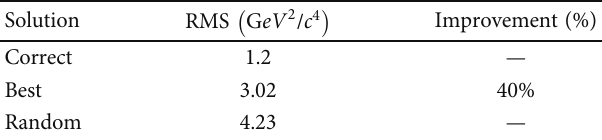
Figure 6: The fl owchart of the methodology. Table 2: Resolution on reconstructed q 2 after selecting one of two solutions and improvements on the resolution of reconstructed q 2 compared to a random